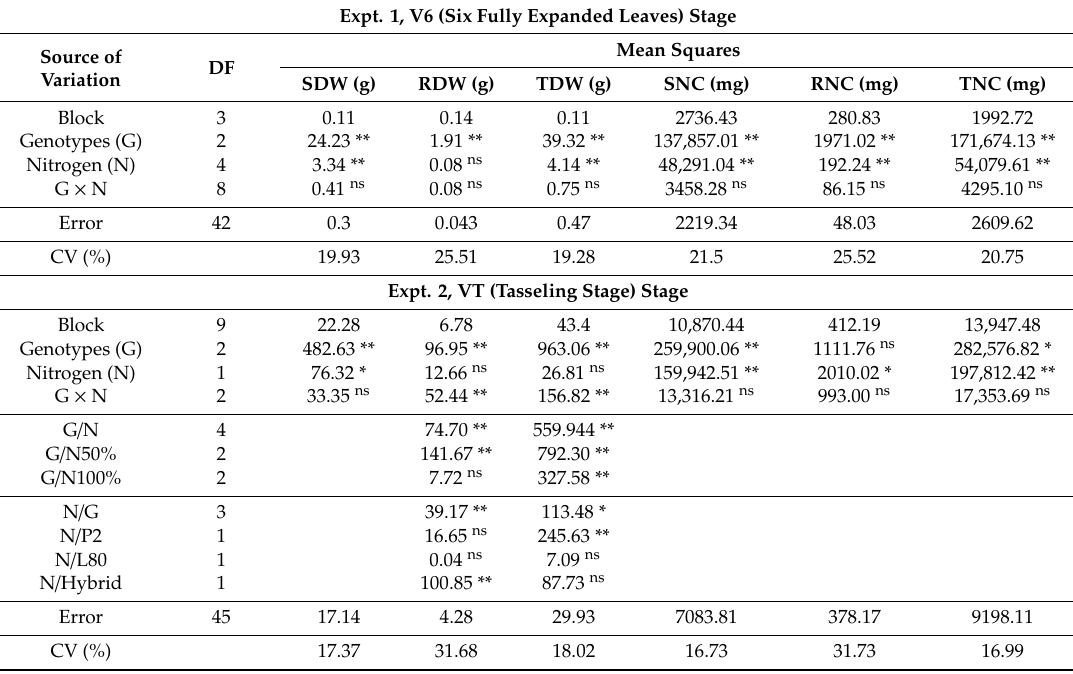
Table 1. Analysis of variance of popcorn genotypes (G), nitrogen levels (N) and G × N interaction for the shoot, root, total dry weight and N content at the V6 and VT